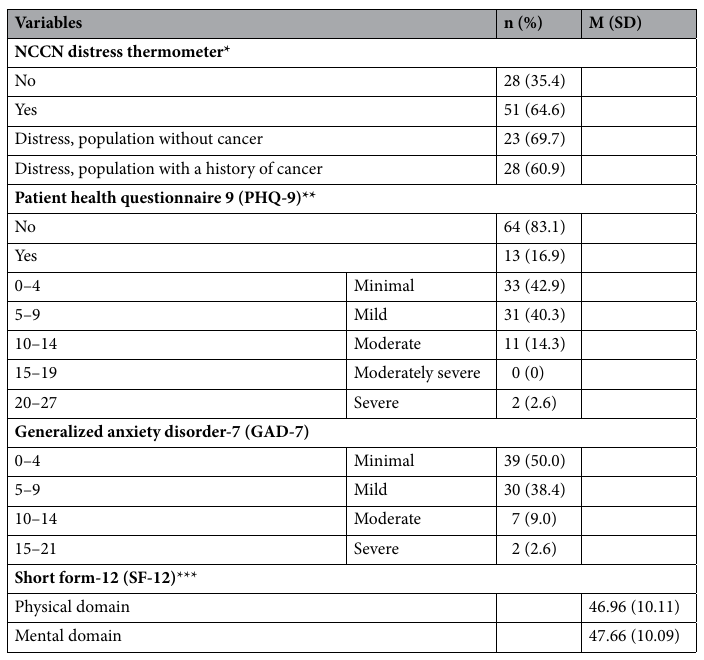
Table 3. Variables of psychological well-being. *Cut-Off ≥ 5 general distress. **Cut-Off ≥ 10 major depression. ***In comparison, the norm means of 41- to 50-year-olds in the general population (1994) were M = 50.15 (SD = 7.93) for the physical domain and M = 52.24 (SD = 7.79) for the mental